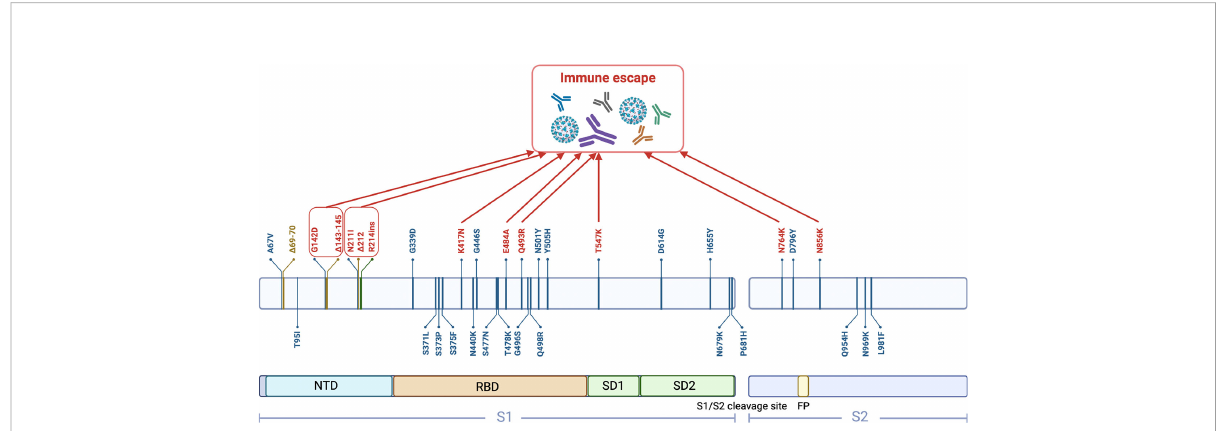
FIGURE 1 Schematic representation of 37 mutations in the BA.1 spike protein. (created with biorender.com). NTD, N-terminal domain; RBD, Receptor- binding domain; SD1, Subdomain 1; SD2, Subdomain 2; FP, Fusion